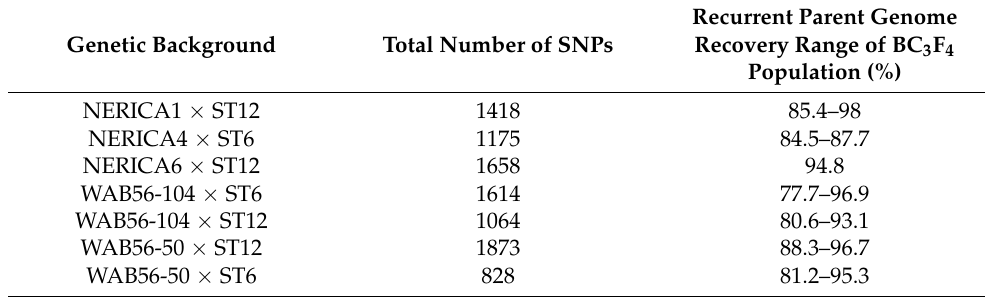
Table 1. Total number of SNPs and recurrent parent genome recovery range of WISH lines